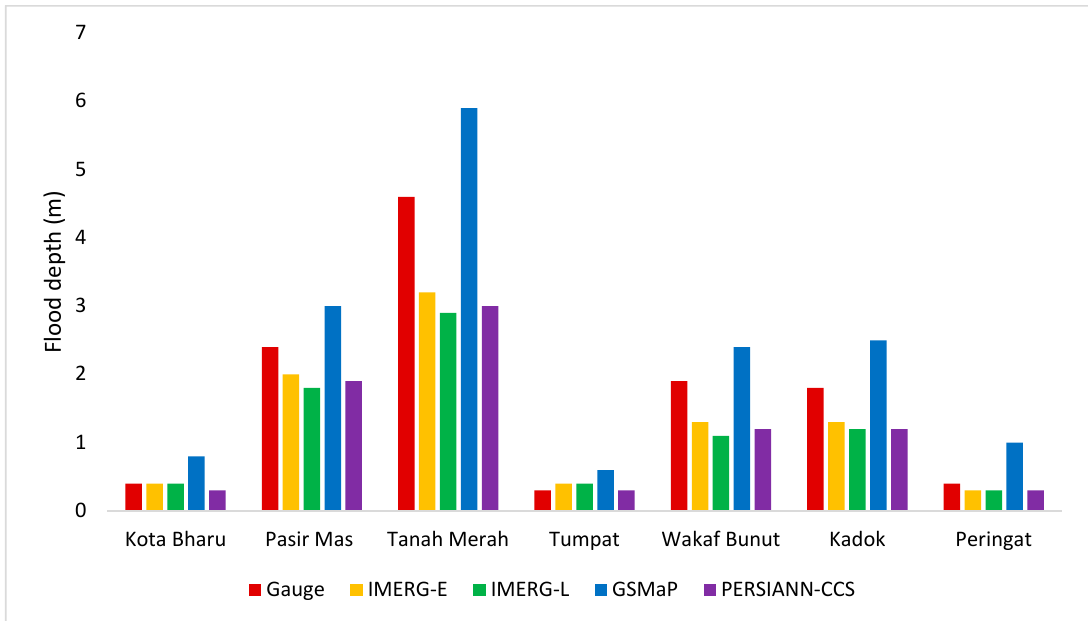
Figure 9. Comparison of flood depth at different towns estimated using different satellite precipitation products and rain gauge data in a hydrological model.